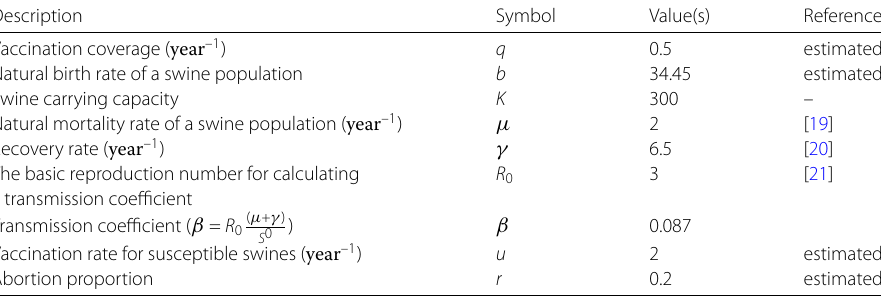
Table 1 Lists of parameters for PRRSV transmission in the model Description Symbol